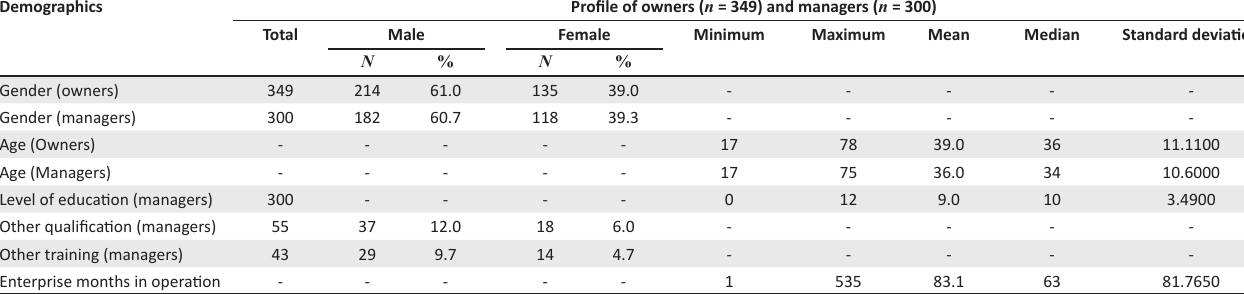
TABLE 2: Demographic profile of owners and managers. Demographics